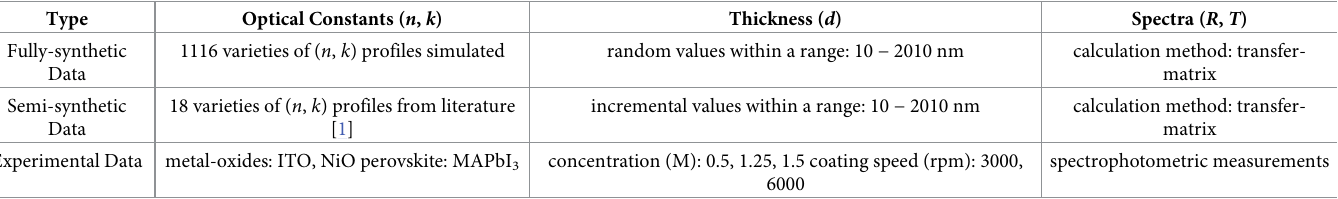
Table 1. Obtaining reflectance and transmittance spectra for different data types. The film thickness in experimental data are measured using combinations of the pro- cess variables (M, rpm). Further details are available in the Data Curation section. Type Optical Constants ( n , k ) Thickness ( d ) Spectra ( R , T ) 1116 varieties of ( n , k ) profiles simulated random values within a range: 10 − 2010 nm calculation method: transfer- Fully-synthetic Data matrix Semi-synthetic 18 varieties of ( n , k ) profiles from literature incremental values within a range: 10 − 2010 nm calculation method: transfer- Data [1] matrix Experimental Data metal-oxides: ITO, NiO perovskite: MAPbI 3 concentration (M): 0.5, 1.25, 1.5 coating speed (rpm): 3000, spectrophotometric 6000